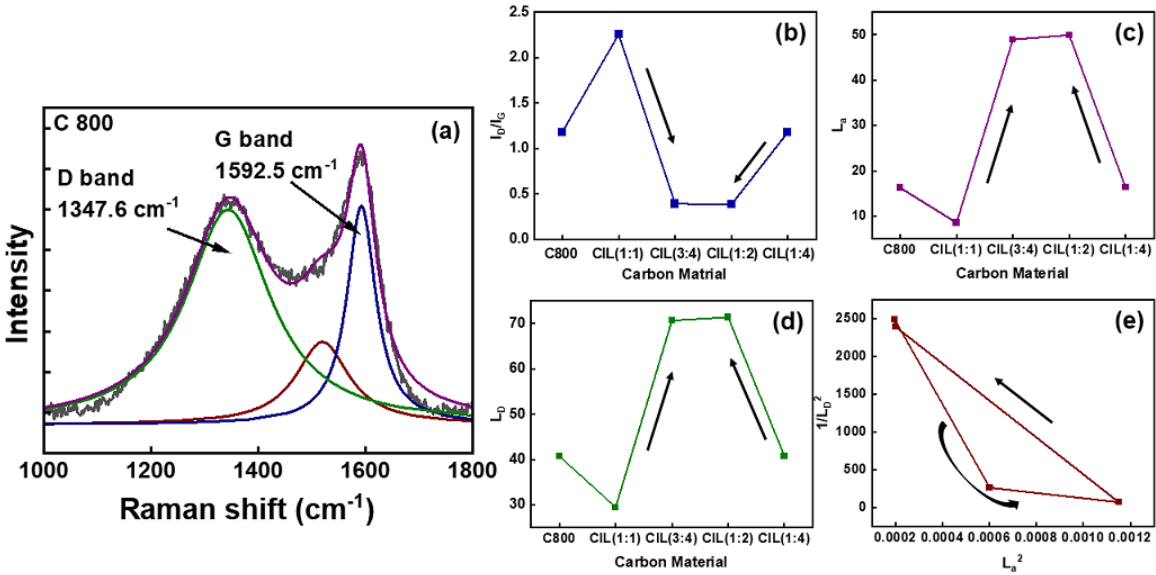
Figure 4. ( a ) Raman spectrum of C800 showing the peak deconvolution and variation of ( b ) I D / I G , ( c ) L a , ( d ) L D and ( e ) 1/ L D 2 vs. L a 2.